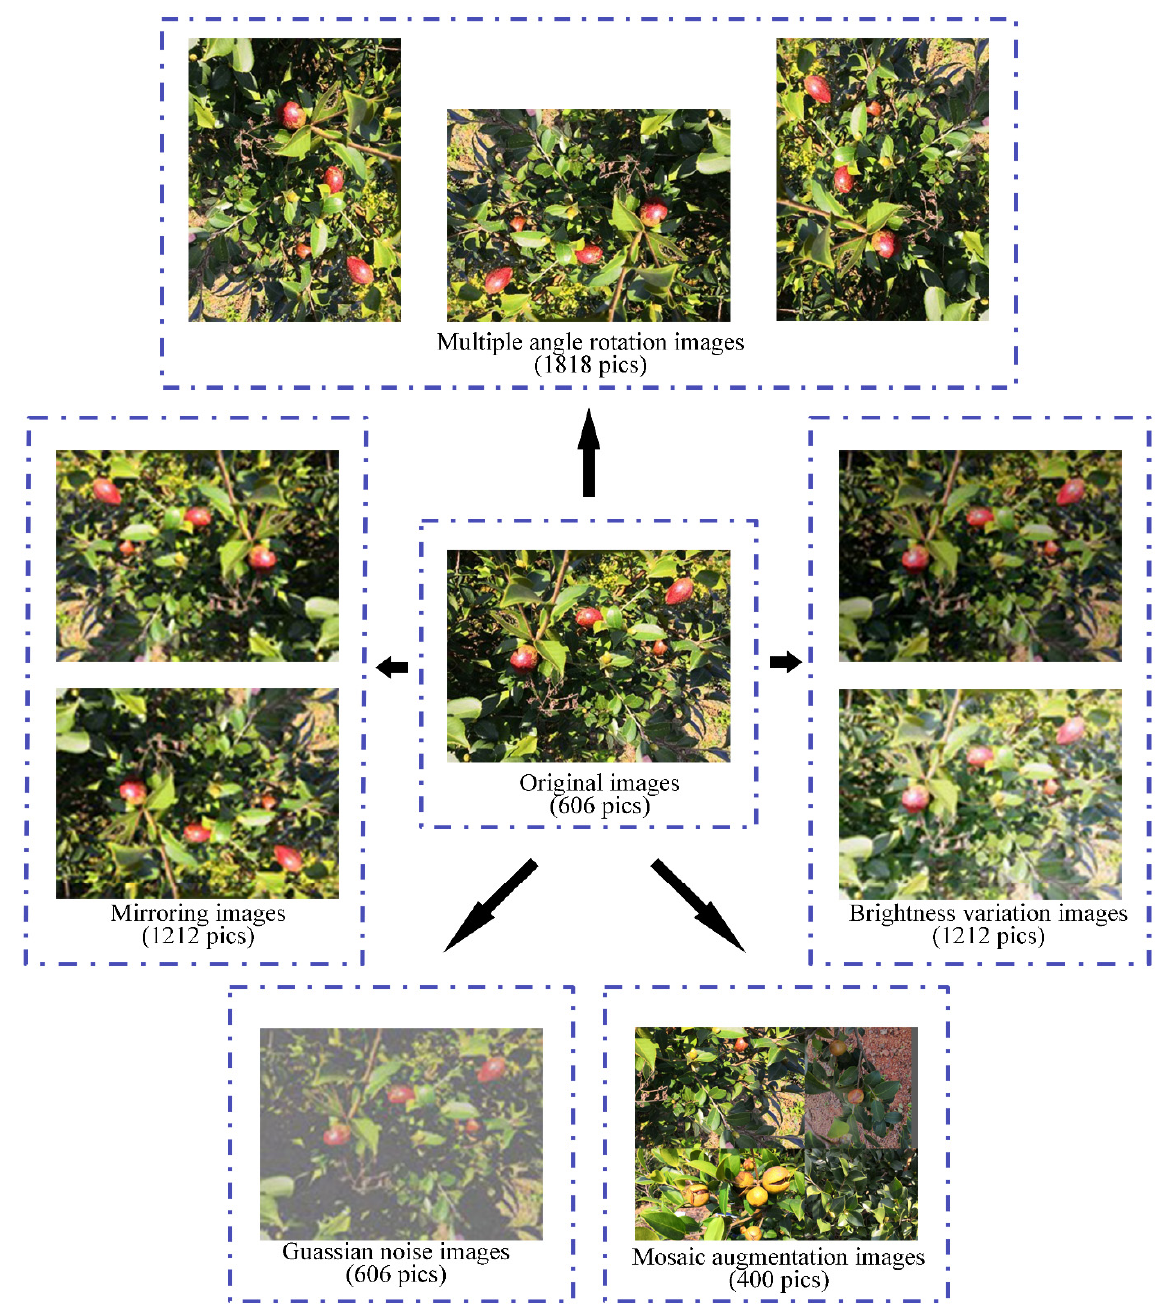
Figure 3. Distribution of the augmented training set.